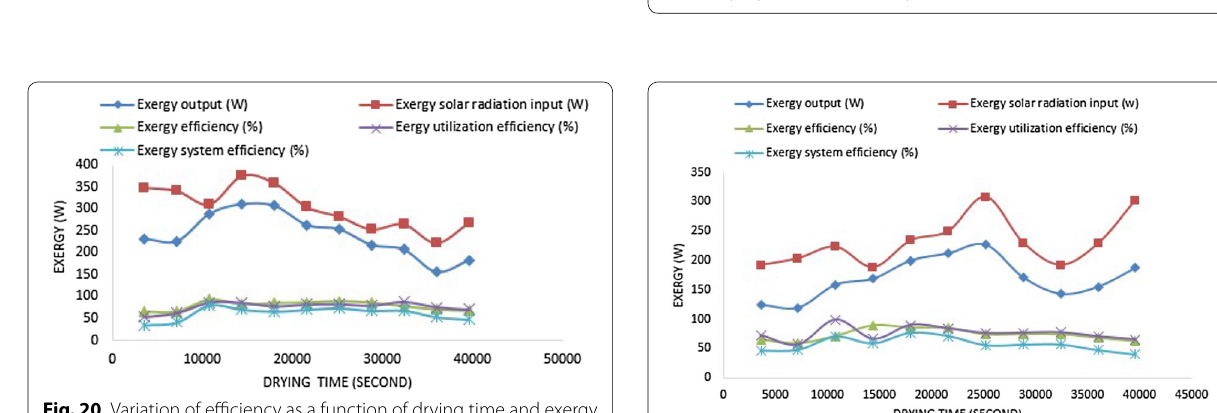
Fig. 20 Variation of efficiency as a function of drying time and exergy in the drying chamber (1st day) onion